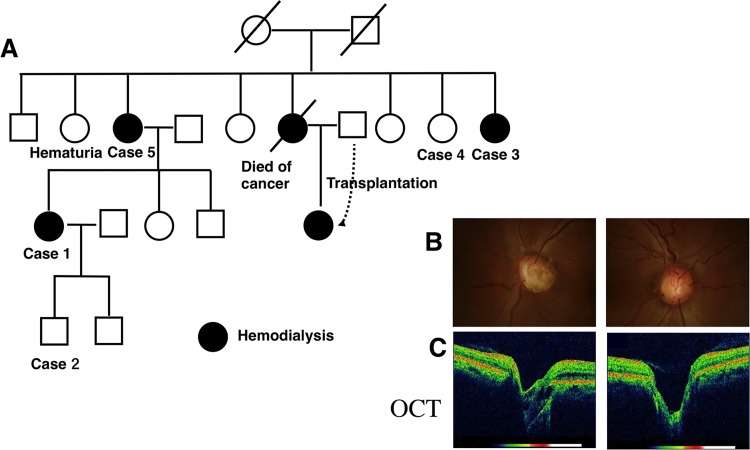
Pedigree of the family with RCS with PAX2 mutations.Pedigree of the family with RCS showing classical autosomal dominant inheritance across three generations. ☐, males; ❍, females; ●, female patients receiving hemodialysis. A diagonal line through a symbol means a patient is deceased.Ocular fundal images of Patient 1 (B, C) indicate that she had ocular coloboma (coloboma scores: right eye = 1, left eye = 3). Cross-sectional images of the optic disc acquired using optical coherence tomography (OCT) show deep excavation in both eyes (C).